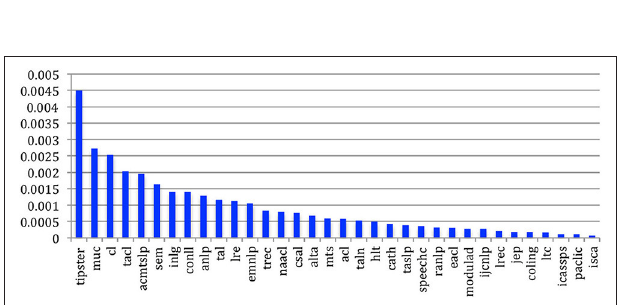
FIGURE 52 | Density of the internal papers citation